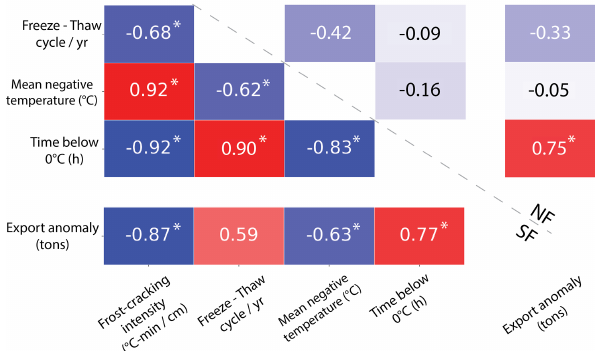
Figure 7. Correlation matrix between different soil temperature in- dicators computed from all data points (using both uphill and down- hill locations on the same slope) and between soil temperature in- dicators and sediment export anomaly (calculated using averages between uphill and downhill locations from the same slope). Lower- left and upper-right parts of the table report correlations for south- facing (SF) and north-facing (NF) slopes, respectively (note that frost-cracking intensity was not calculated for north-facing slopes; see text). Blue boxes show negative correlations and red boxes show positive correlations; values indicate the correlation coefficient R and stars (*) indicate significant correlations (i.e., p < 0 . 05).